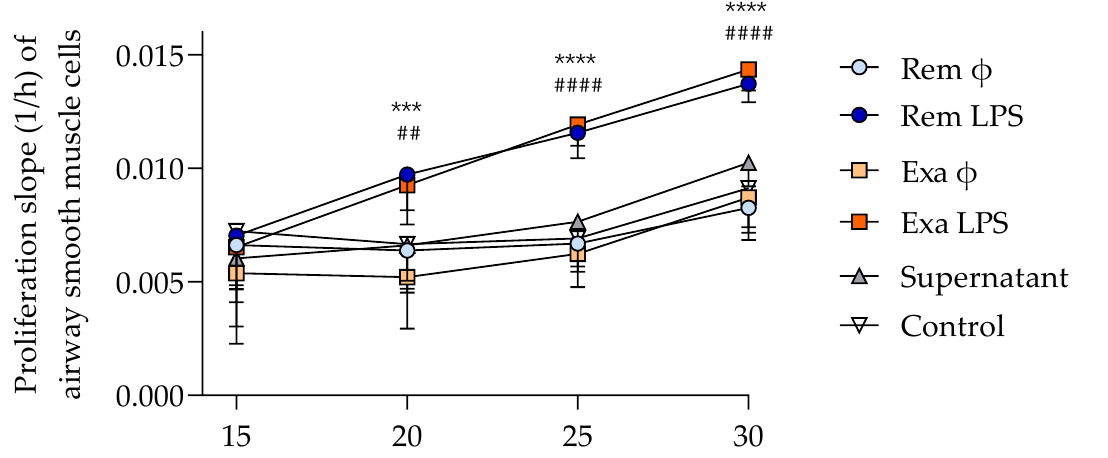
Figure 7. Airway smooth muscle proliferation studied with the Xcelligence device (mean ± SEM). φ : untreated cells; LPS: cells treated with 100 ng/mL of LPS. *** p < 0.001, **** p < 0.0001 between REM (remission) + LPS and control; ## p < 0.01, #### p < 0.0001 between EXA (exacerbation) + LPS and control with Bonferroni multiple comparison tests.